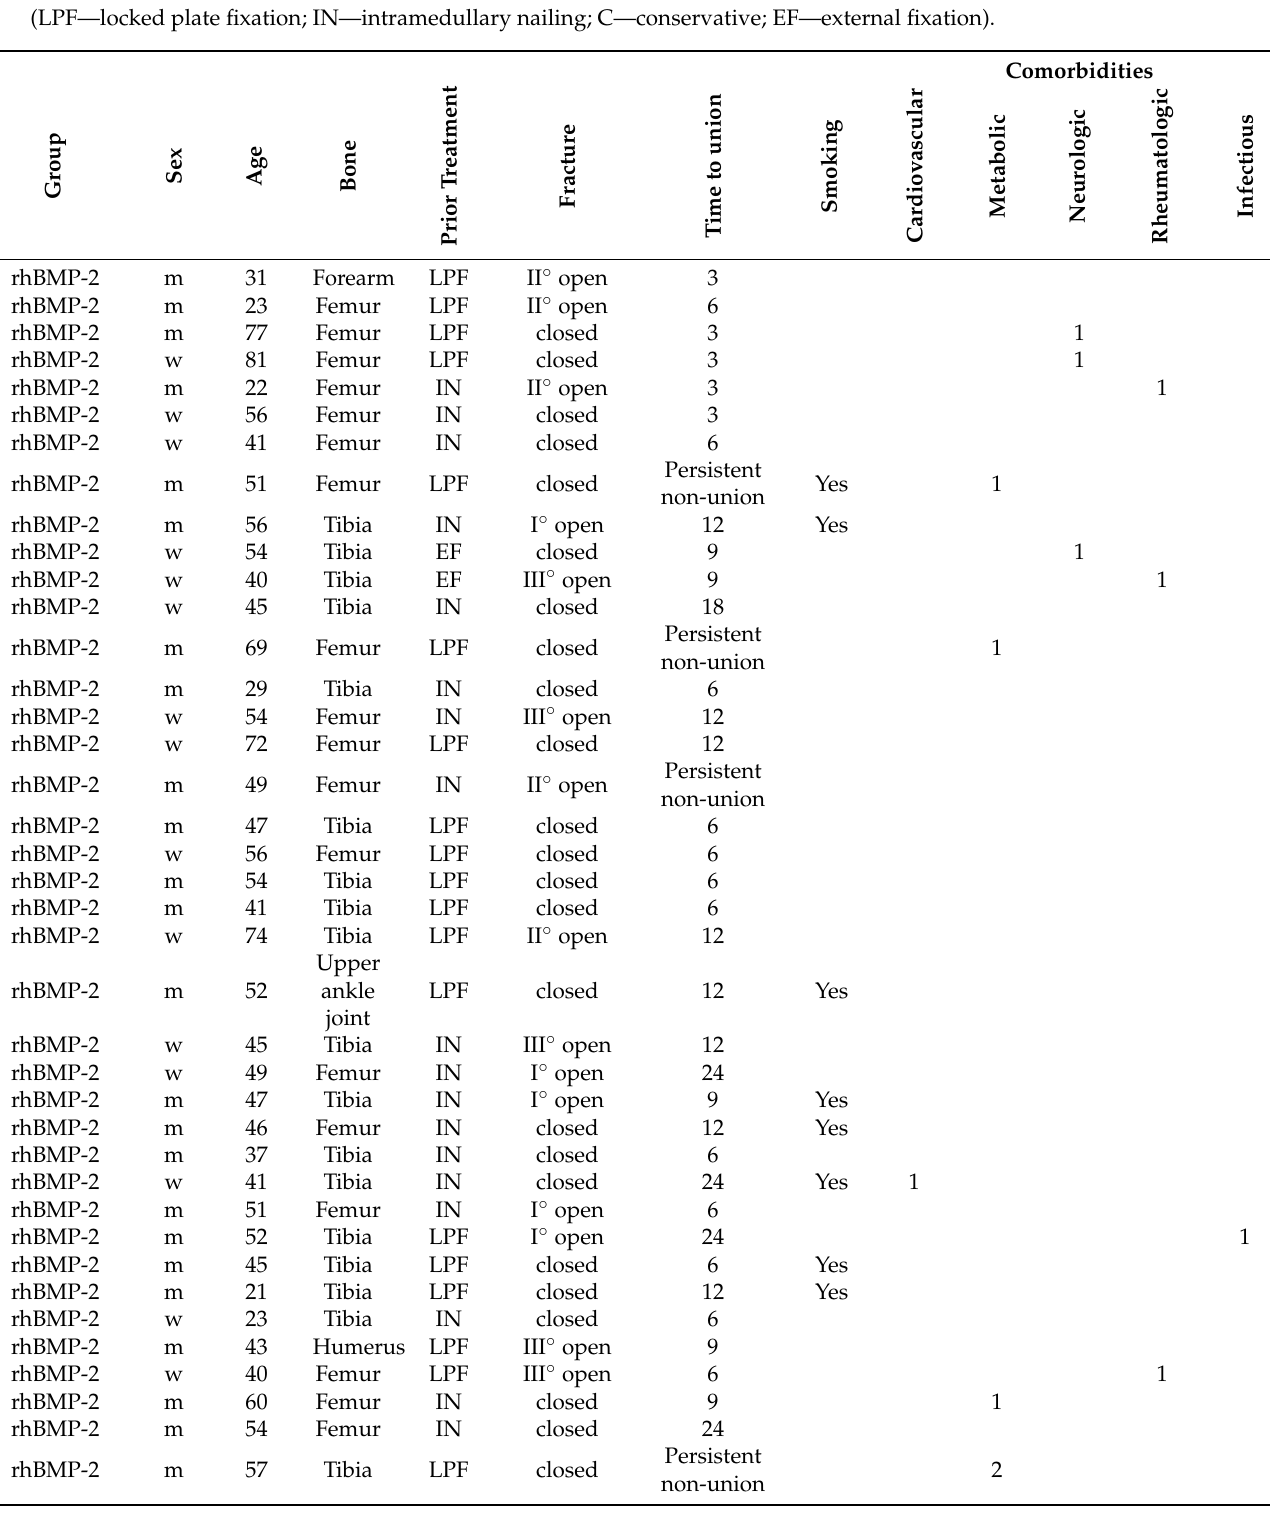
Table 2. Patient characteristics including age, sex, prior treatment, treatment group, time to union, and comorbidities (LPF—locked plate fixation; IN—intramedullary nailing; C—conservative; EF—external fixation).